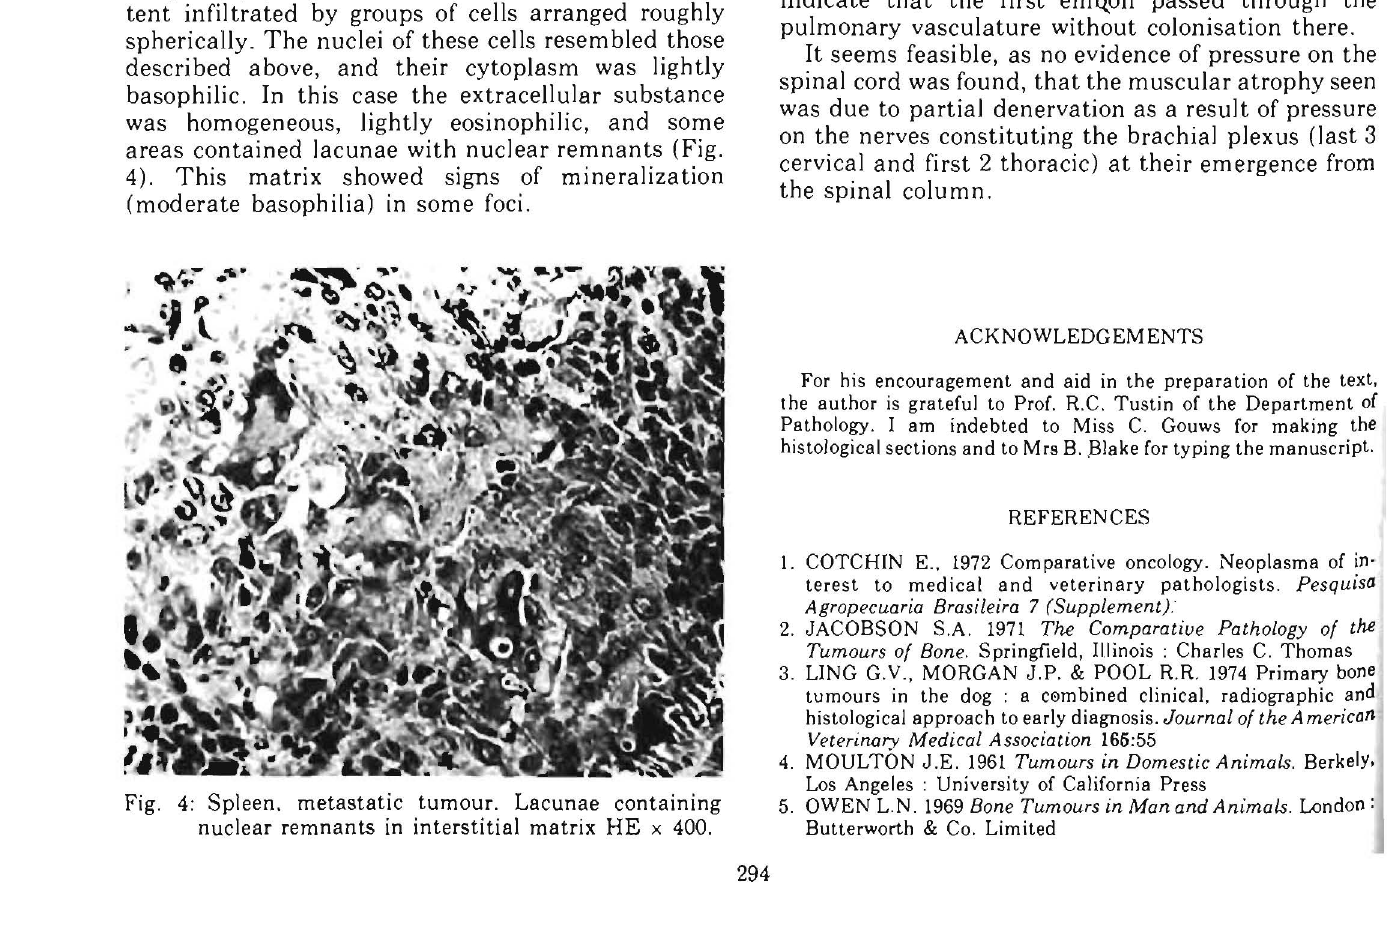
Fig. 3: Ogteosarcoma. Cell detail. HE x 400.